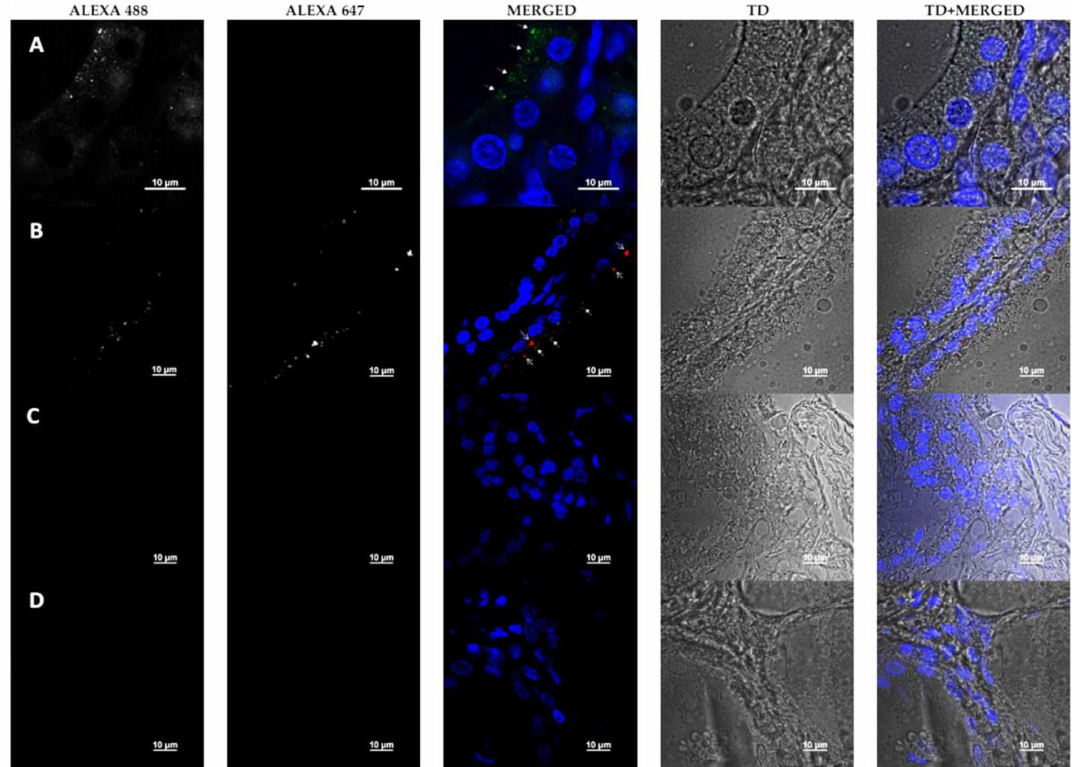
Figure 4. Fluorescent microscopy of thyroid gland tissue. Dyes: DAPI—nucleus; Alexa488—HHV-6 gp82 / 105 (closed tip arrows (bold)); Alexa647—RANTES (opened tip arrows (sharp)); TD—transmitted light. Channels Alexa488 and Alexa647 are shown in greyscale for better contrast. Row A—part of a thyroid lobule of a patient with Grave’s disease; Row B—limitrophe zone of two separate thyroid follicles of a patient with Grave’s disease; Row C—control patient’s (with adenoma) thyroid lobule; Row D—staining control (secondary antibodies and DAPI